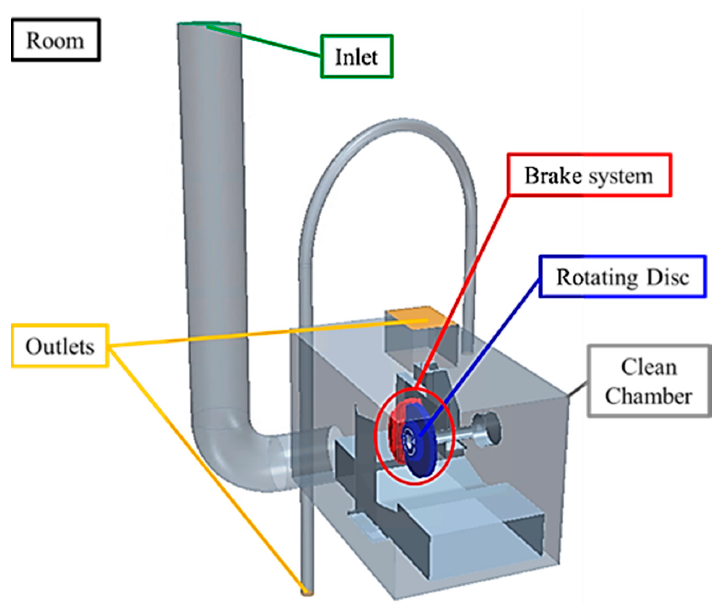
Figure 3. An overview of the pin-on-disc (PoD) setup with its important parts marked [15].